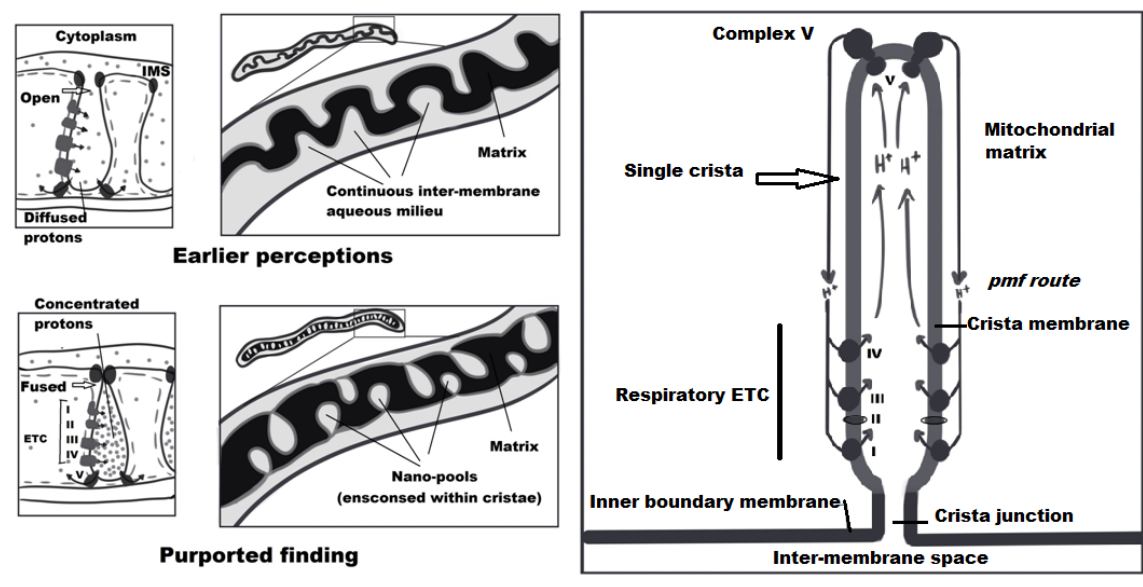
Figure 2: The main message of Wolf et al paper is redrawn, along with Schlame’s image supporting the ideas mooted by Shirihai group. Quite simply, the researchers have the proton counts totally wrong, as it is only finger-countable! Schlame supports their finding with a beautifully ordered arrangement of ETC and cyclically directional flow of protons! Such a wishful portrayal is a betrayal of fundamental molecular awareness in